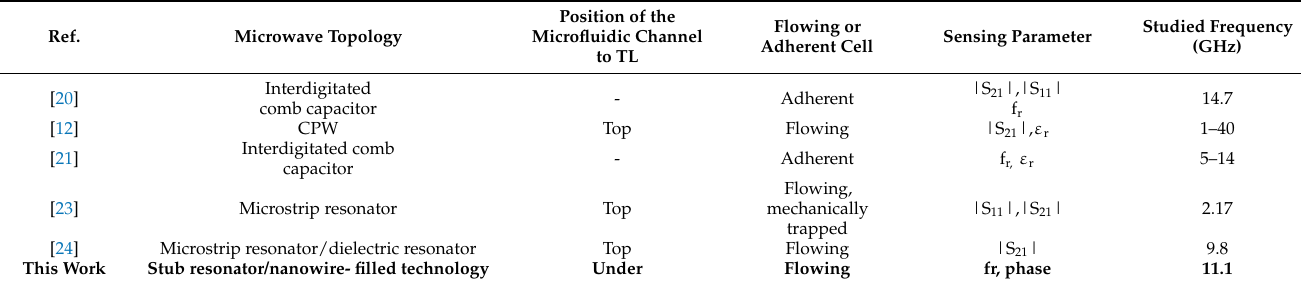
Table 1. Comparison with the State-of-the-art label-free microwave-based sensors.